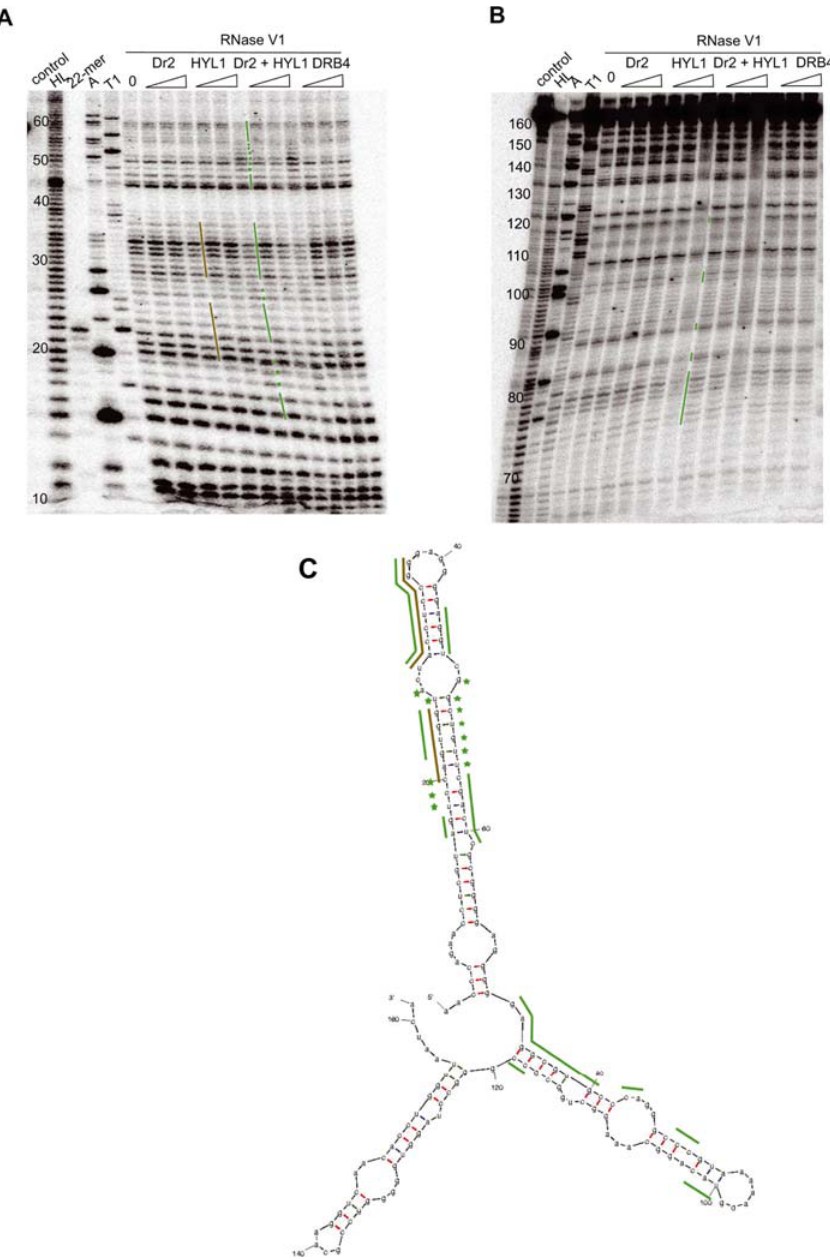
Figure 3. Protection from RNase V1 digestions of SINE RNA by two different dsRBPs. Prior to RNase V1 digestion, in vitro transcript of SB1 was subjected to protection by increasing concentrations of expressed dsRBPs: Dr2 (the second dsRBD of Xenopus laevis ADAR1), HYL1, combination of Dr2 and HYL1, or DRB4. Regions protected by Dr2 and HYL1 are marked alongside short run gel (A), long run gel (B) and predicted folding pattern (C) by brown and green bars, respectively. Three independent experiments gave similar results as the one presented. Nucleotides marked with asterisks seem to adopt more prominent helical structure upon protein binding and, therefore, become more prone to RNase V1 cleavage. DRB4 is showing no effect on RNase V1 cleavage, confirming its low in vitro binding affinity to SB1 RNA. Dr2 and HYL1, in this case, bind to and protect similar regions of RNA. HYL1 is, however, showing stronger binding affinity than Dr2. (HL) represents a partially hydrolyzed RNA ladder. Denaturating RNase A and T1 digests give the position of pyrimidine and G residues respectively. The control lane shows untreated RNA samples and the (0) lane represent RNase V1 digestion without recombinant proteins added. A labeled 23-mer oligoribonucleotide was also loaded on the gel to help in band size determination.